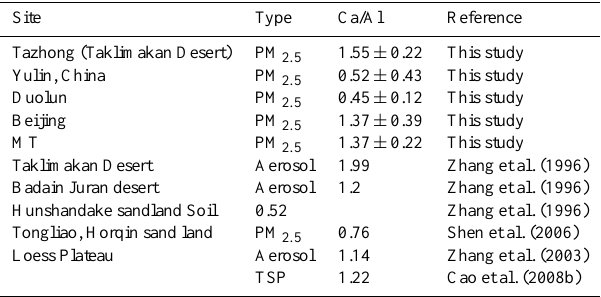
Site Type Ca/Al Reference Tazhong (Taklimakan Desert) PM 2 . 5